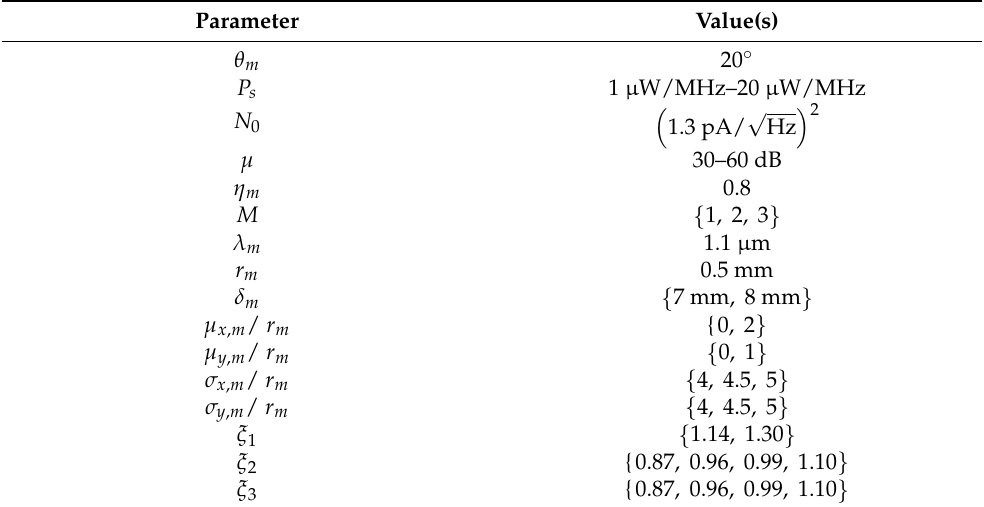
Table 2. Link parameter